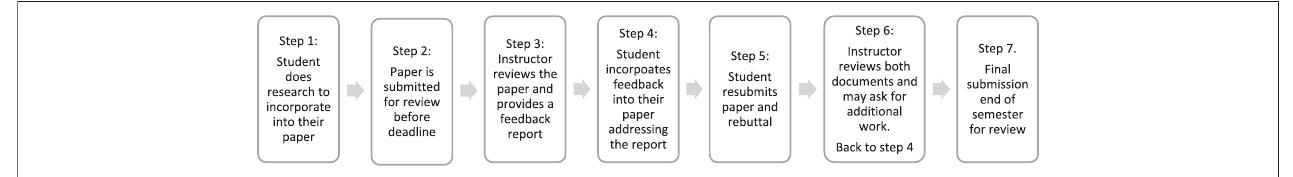
FIGURE 1 | Proposed assessment of student